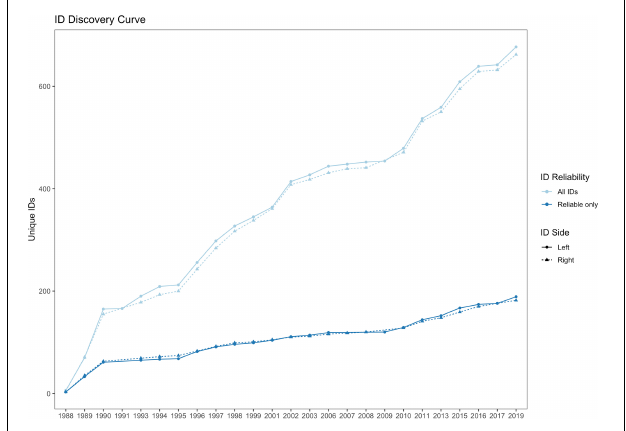
FIGURE 7 | Cumulative discovery curve of all unique IDs (light blue line) and reliable IDs only (dark blue line), plotted for left and right sides,